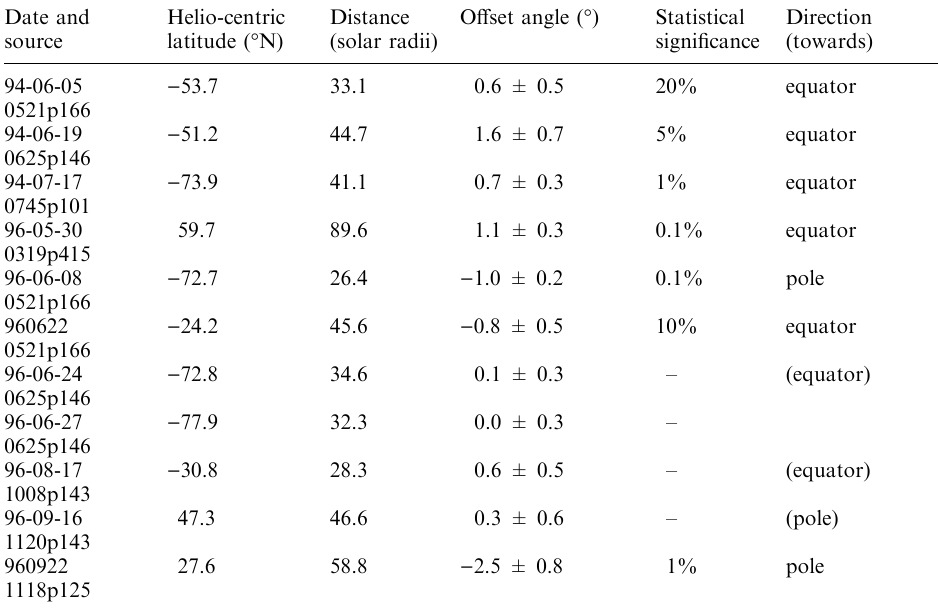
Table 1. Results from the ele- ven extended-run observations. Date and